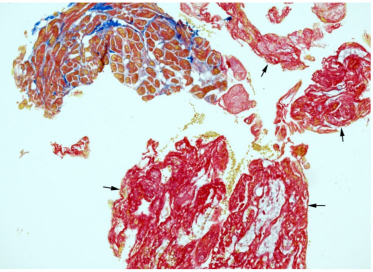
Figure 3. Clinically overt cardiac involvement in GPA is rare (3.3%) [4]; therefore, it may be easily overlooked. Pericarditis is the most common symptom in symptomatic patients (35%) [4], but only a few reports have described myocarditis caused by GPA [10]. Although pericarditis is usually mild, it can relapse or progress to constrictive pericarditis and tamponade [11], whereas myocarditis can lead to congestive heart failure or life-threatening arrhythmia [12]. Cardiac involvement in GPA